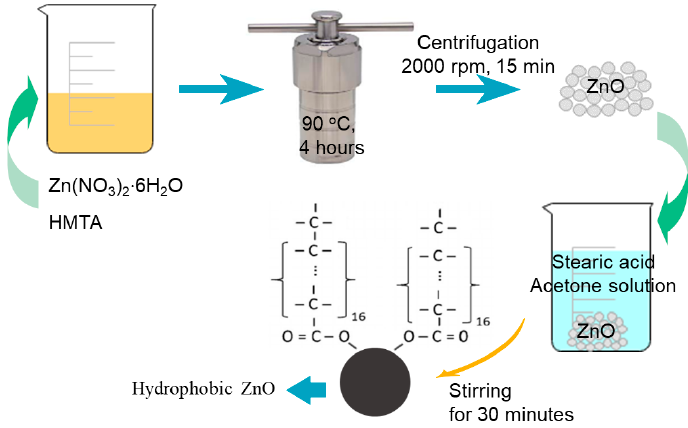
Figure 1. A schematic illustration of the hydrophobic ZnO micro/nanoparticles.